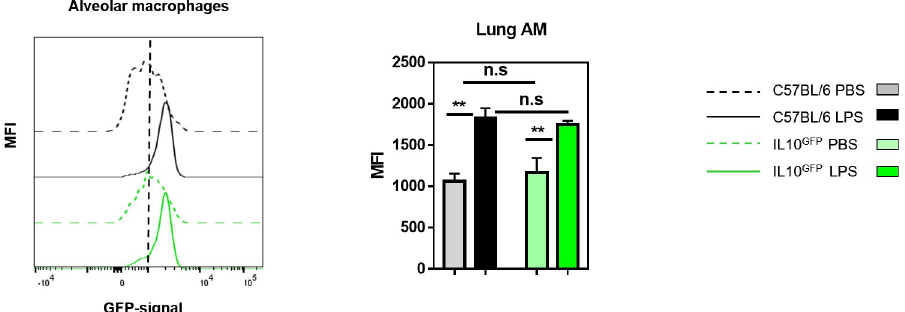
Fig 4. The autofluorescence of alveolar macrophages increases during lung inflammation. C57BL/6 and IL-10 GFP mice were subjected to three daily administrations (d0, d1, d2) of 10 μ g LPS per mouse via aspiration. 16–18 hours after the last administration, the single-cell suspensions from the lungs were analysed. Representative histogram showing the GFP-signal from alveolar macrophages (CD45 + CD45R/B220 - CD3 ε - Siglec-F + F4/80 + CD11b - ) from C57BL/6 and IL10 GFP mice as indicated. The data shown are representative of three independent experiments (PBS: n = 9 mice/group, LPS: n = 13–15 mice/group in total).